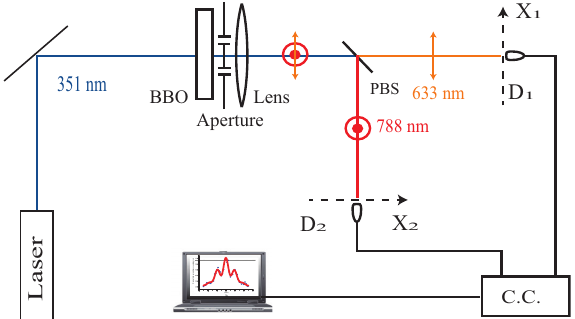
Figure 1. Schematic setup of the experiments. When one of the fiber tips is scanned and the other fiber tip is fixed, the ghost interference-diffraction of the object is measured. When both fiber tips are scanned synchronously along the directions of arrows as shown in the figure, the non-degenerate quantum lithography of the interference-diffraction pattern of the object is measured. C.C., coincidence